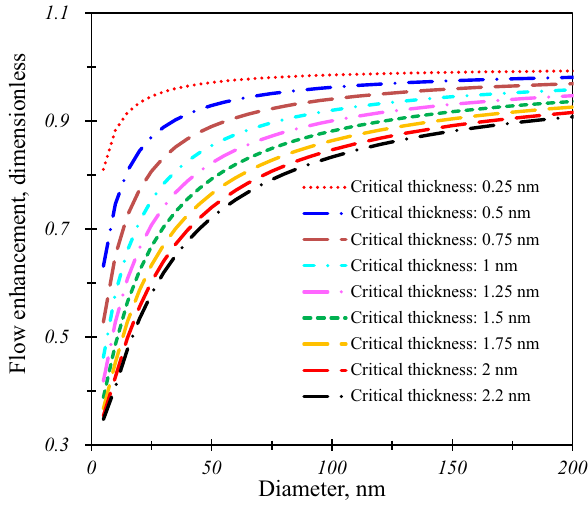
Fig. 4 Relationship between flow enhancement and diameter under various critical thickness